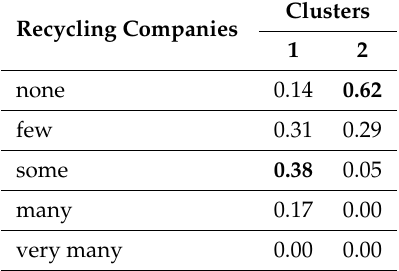
Table 16. Distribution of the categorical variable “recycling companies in the surroundings of the